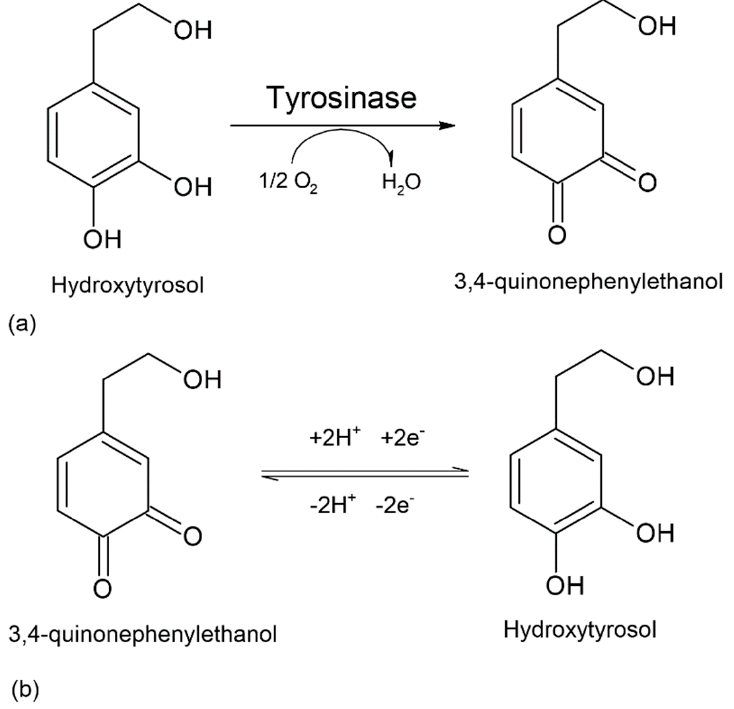
Figure 7. ( a ) Tyrosinase-catalysed oxidation of hydroxytyrosol; ( b ) reversible electrochemical reduction of hydroxytyrosol at the biosensor surface.